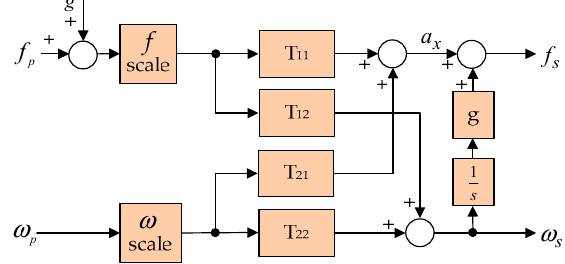
(59), the equation is expressed as shown in Figure 5.